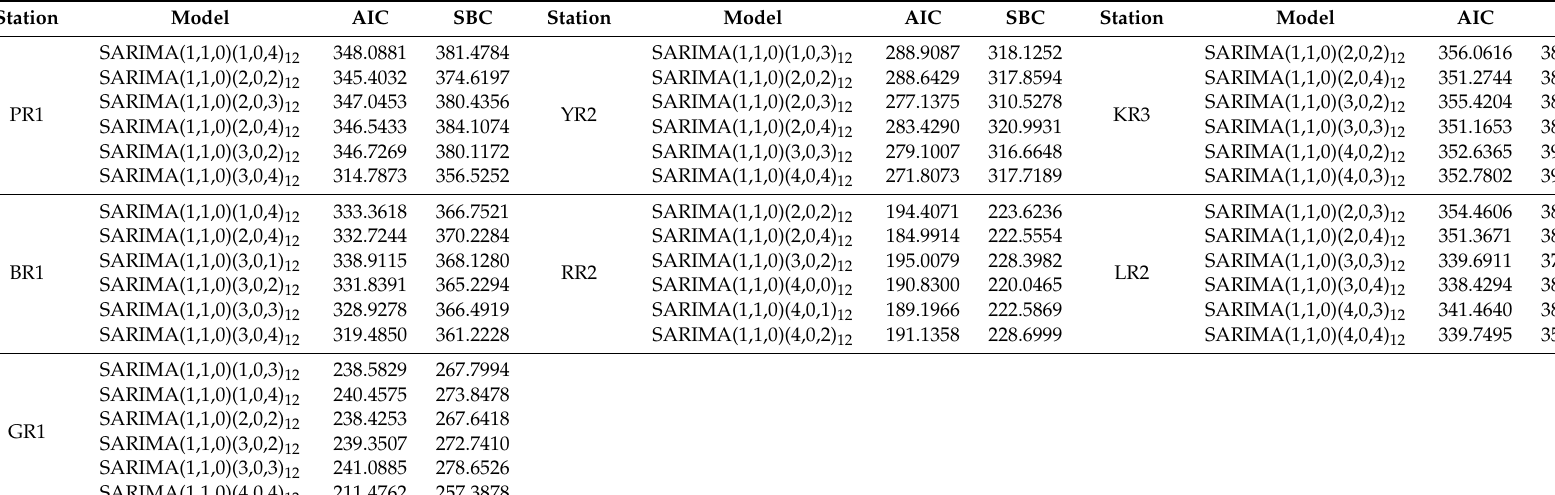
Table 2. The Akaike information criterion (AIC) and Schwarz–Bayesian criterion (SBC) parameters of each station for selected candidate autoregressive integrated moving average (ARIMA)